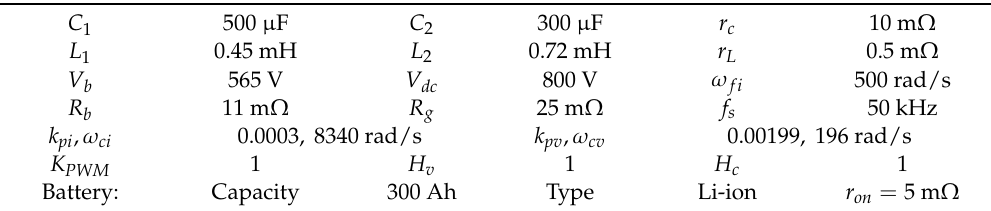
Figure 9. Load resistance variation for the test case presented in Table 2. Table 2. Parameters of the proposed BDC.